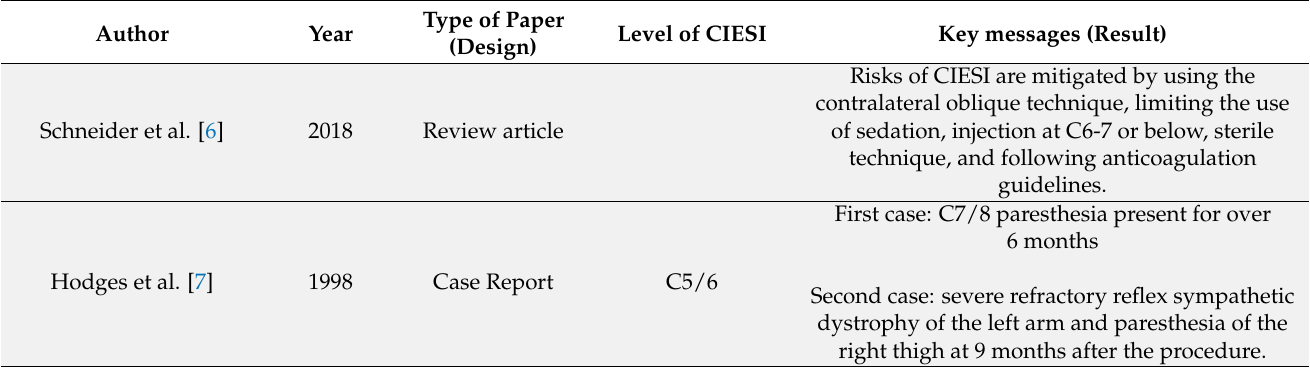
Table A1. Results of the most significant recent investigations on cervical interlaminar epidural steroid injection for the treatment of cervical radicular